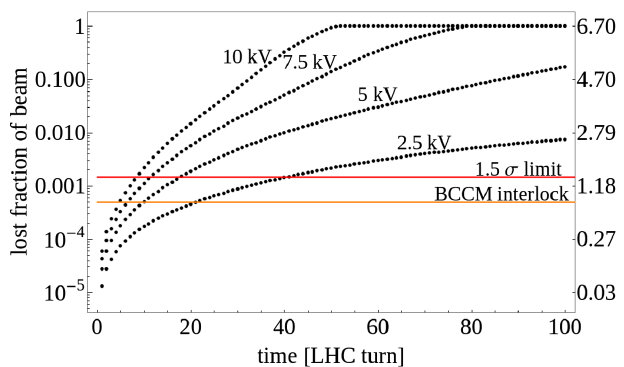
FIG. 22. Estimate of the lost fraction of beam over time for ADT kicks with varying voltages and a beam energy of 7 TeV. The red line indicates the 1 . 5 σ limit, whereas the orange line shows the interlock limit of the beam current change monitor